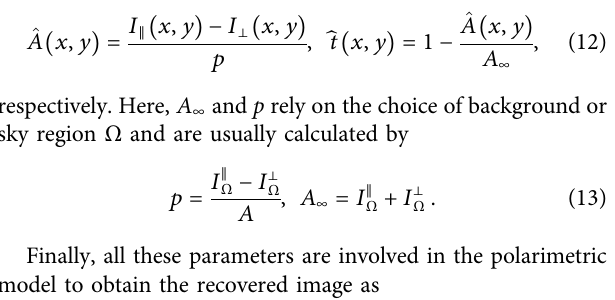
Frontiers in Physics |